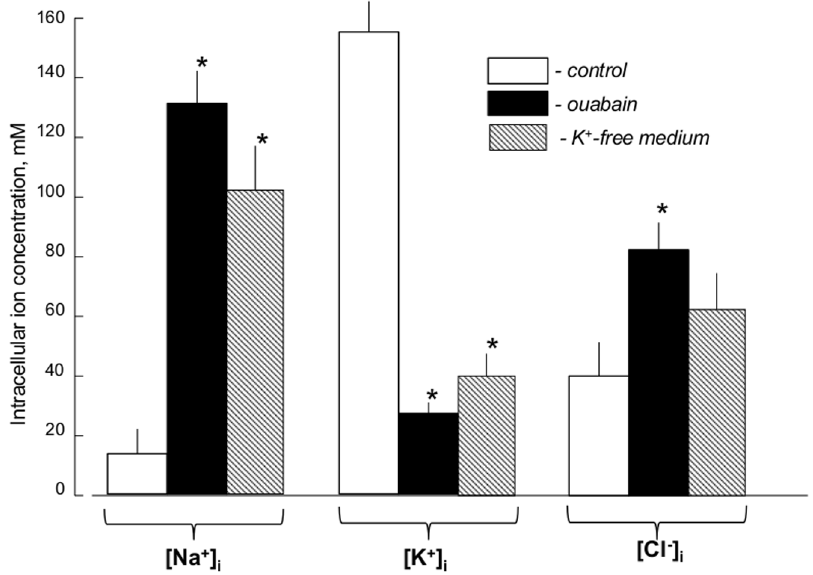
Figure 1. Effect of Na + ,K + -ATPase inhibition on the intracellular content of monovalent ions. RASMC were incubated in control and K + - free medium or in the presence of 3 mM ouabain for 6 hr. Means 6 S.E. from 3 independent experiments performed in quadruplicate are shown. *p , 0.05 compared to controls.